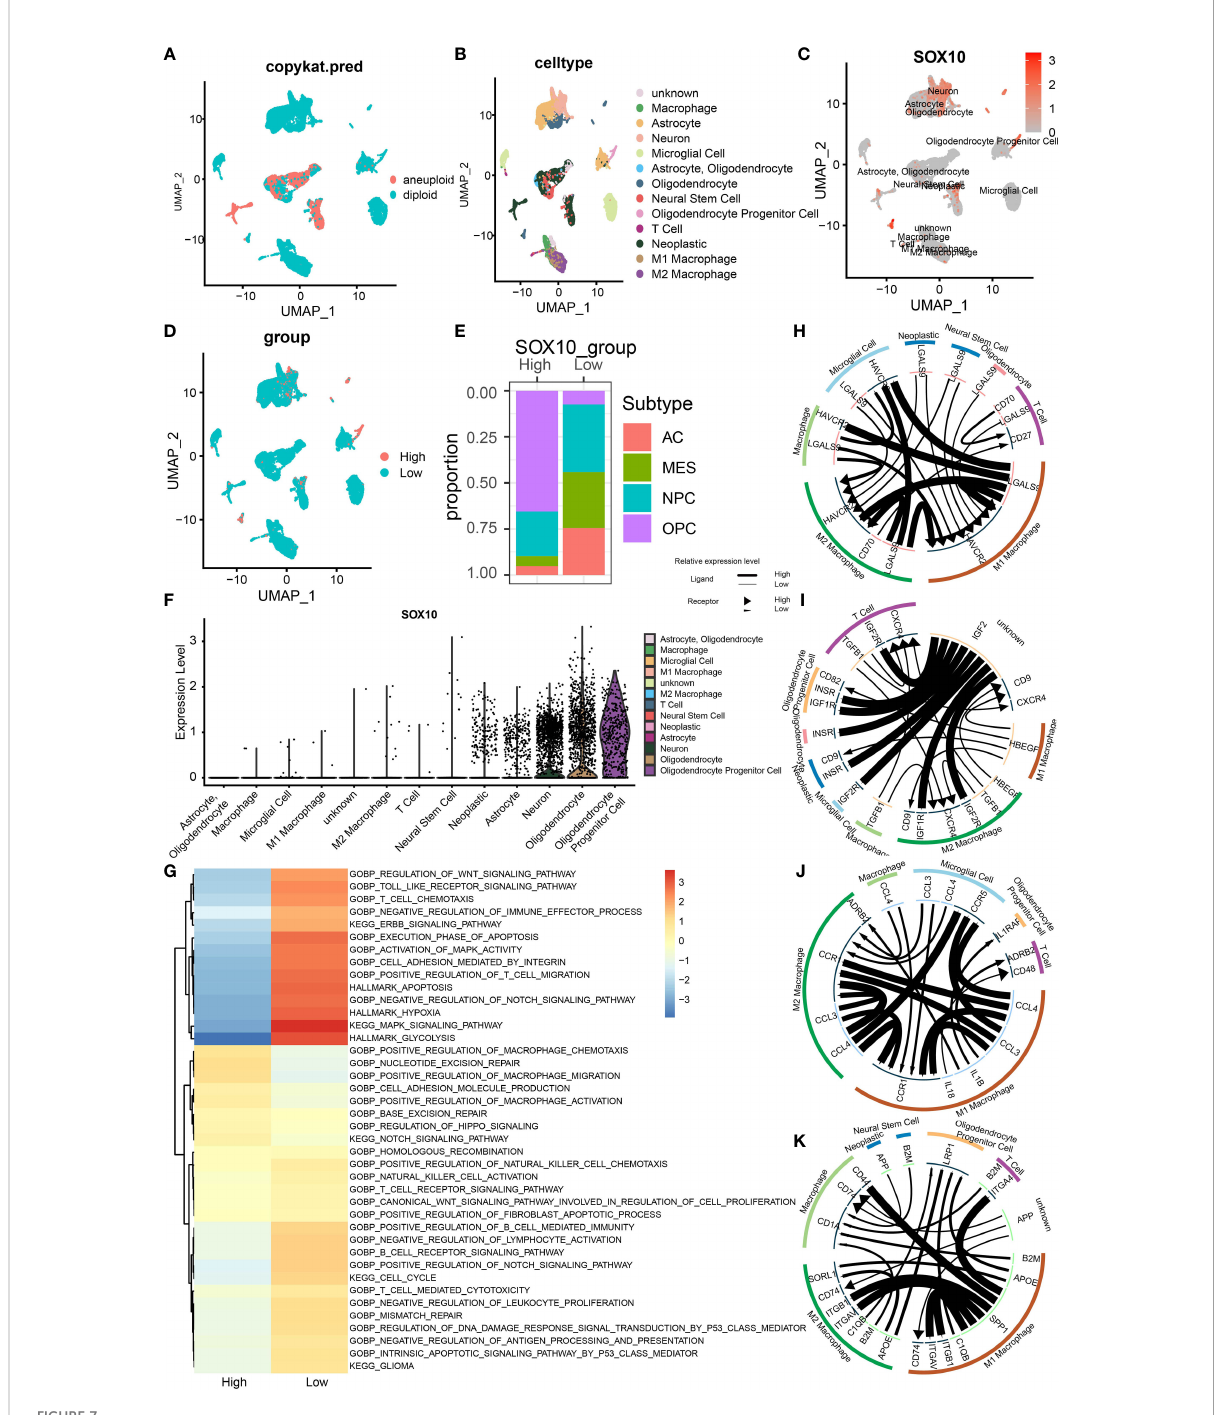
FIGURE 7 Strati fi cation, identi fi cation, and SOX10 co-expression on glioma cells by single-cell sequencing analysis. (A) UMAP projection determined by CopyKat analysis. (B) UMAP projections of different cells, color-coded by cell types. (C) Annotation of different cell types and the expression of SOX10 in each cell type. (D) UMAP projections of two cell groups based on the expression of SOX10. (E) The proportion of glioma subtypes in the high and low SOX10 expression group. Astrocytes (AC), neural progenitor cells (NPC), mesenchyme (MES), and oligodendrocyte precursor cells (OPC). (F) Violin plot of SOX10 expression distribution of divergent cell clusters. (G) Enrichment analysis correlating divergent immune regulatory processes with high and low SOX10 expressions. (H) Correlation circles for positively and negatively correlated checkpoint genes in the high expression group of SOX10. (I) Correlation circles for positively and negatively correlated growth factors in the high expression group of SOX10. (J) Correlation circles for positively and negatively correlated cytokines in the high expression group of SOX10. (K) Correlation circles for positively and negatively correlated other genes in the high expression group of